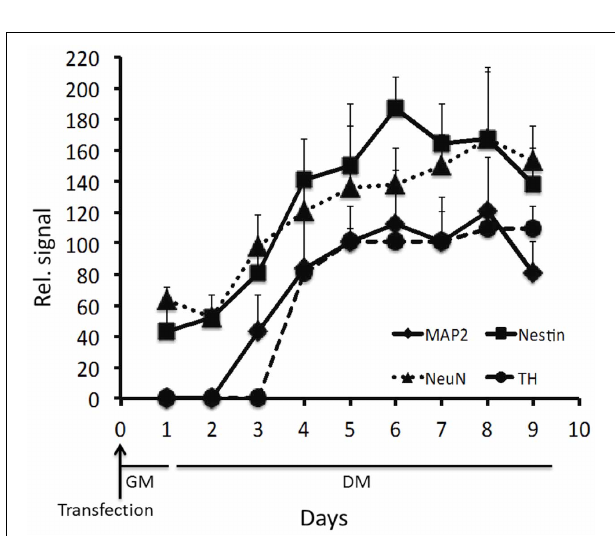
FIGURE 6 | Relative signal for the respective MB. The fluorescence was measured 1 day after transfection, and subsequently every day for 8 days of differentiation. Results from three independent experiments are presented as mean ± standard error of the mean (s.e.m).